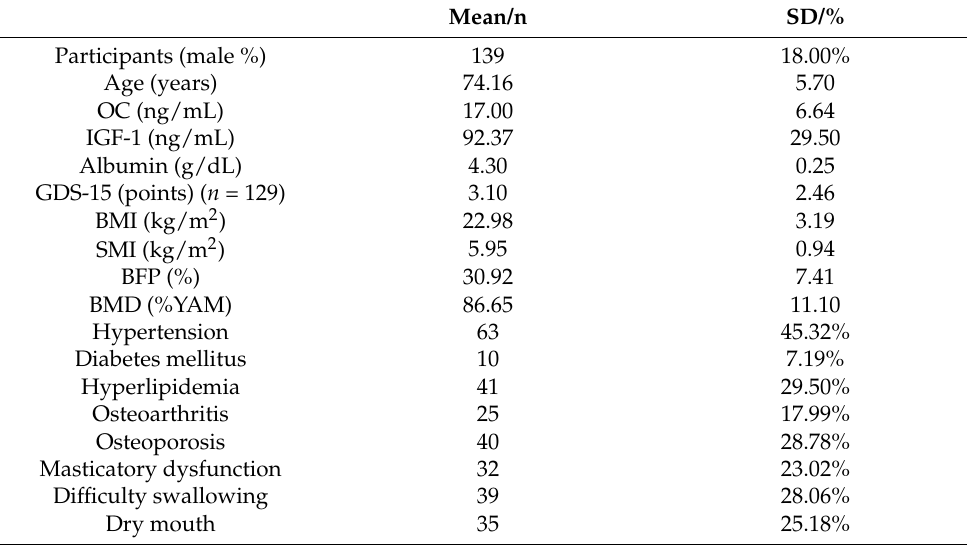
Table 1. Characteristics of the study